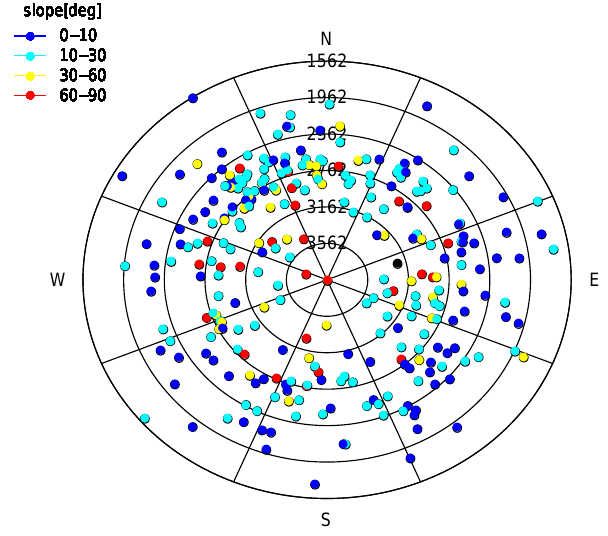
Figure 3. Polar plots describing topographic distribution of valida- tion sites. Elevation range 1560–3750ma.s.l.; slopes 0– > 90 ◦ ; and all aspects are